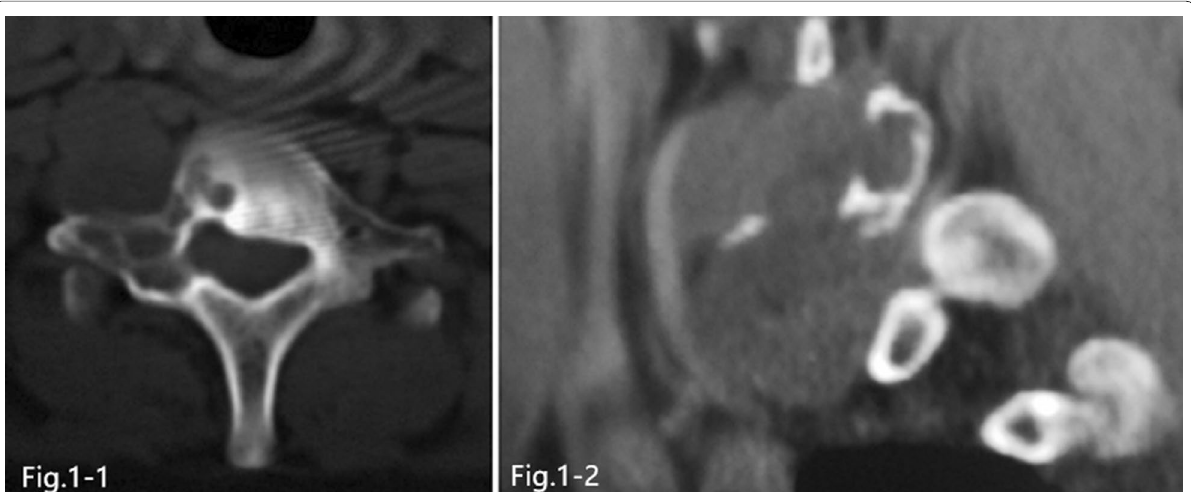
Fig. 1 (1-1) CT bone window axial image. The intraosseous lesion is microcystic type. The tumor shows multiple cyst-like osteolytic bone destruction and has sclerotic margins. (1-2) CT soft tissue window sagittal image. Tumor shows lower density than surrounding bone and soft tissue. The tumor is lobulated with breakthrough bone cortex projecting outward in an ovoid shape, compressing surrounding soft